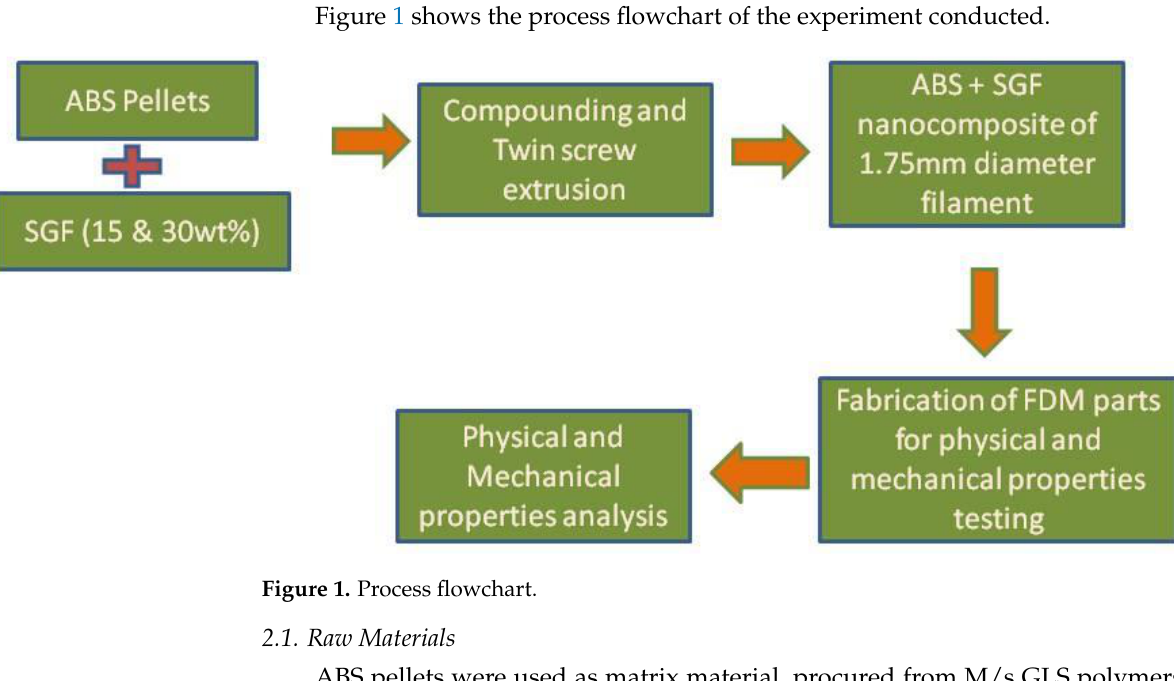
Figure 1. Process flowchart.